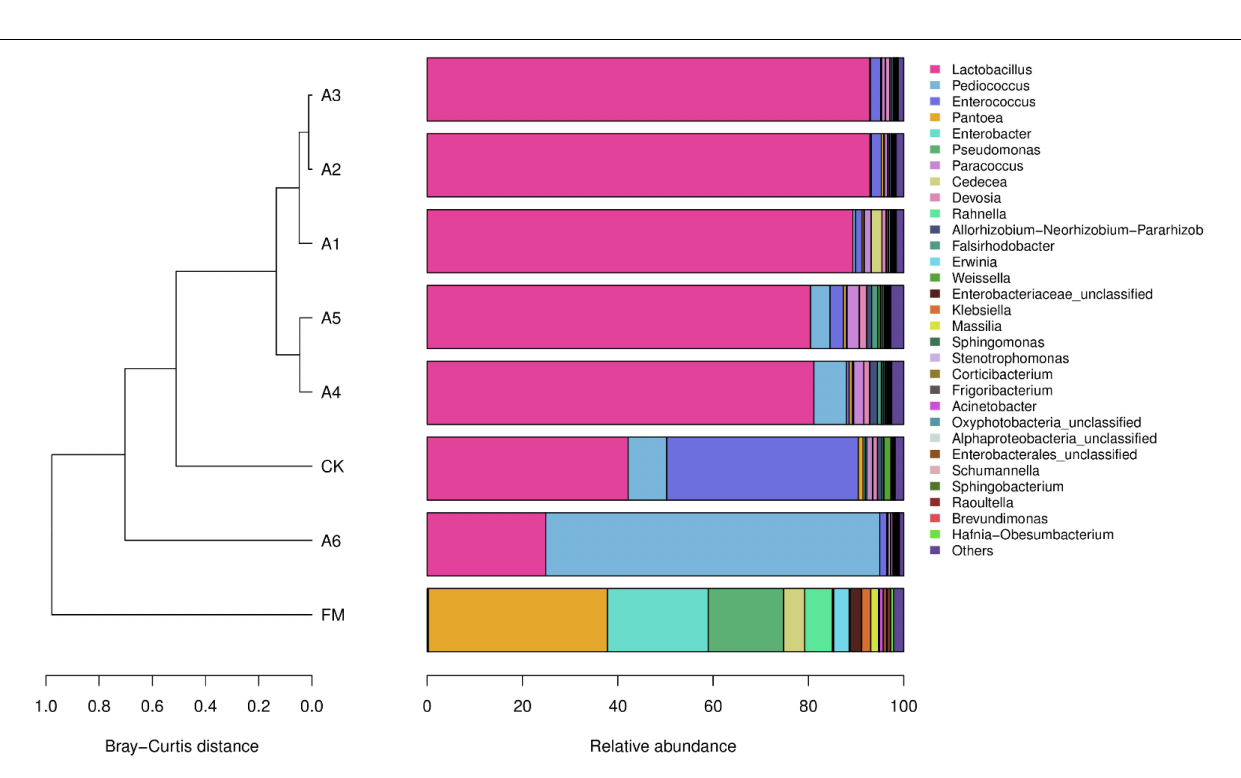
Frontiers in Microbiology |